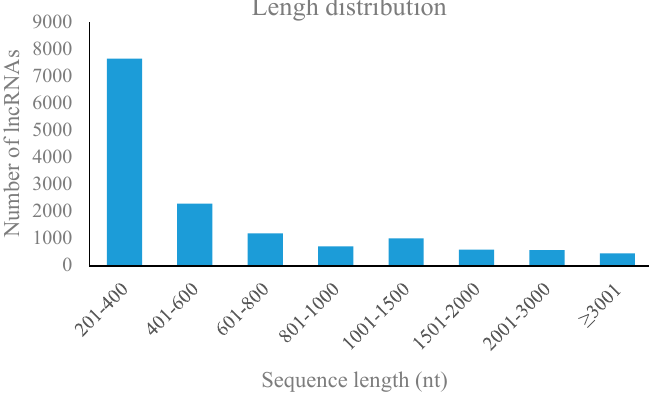
Figure 2. Length distribution of the 14,478 pear lncRNAs.